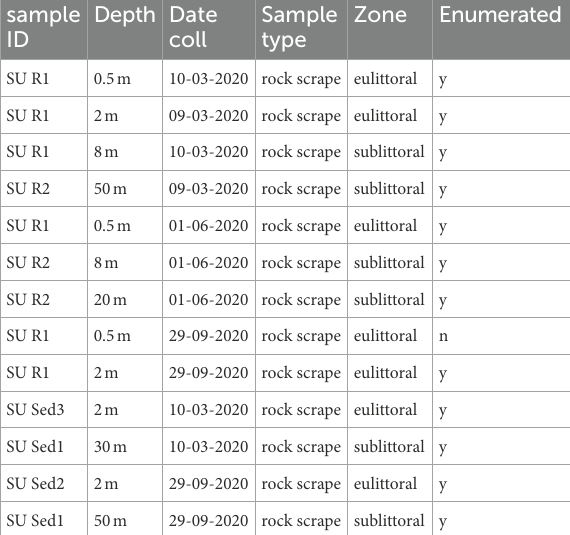
TABLE 2 List of samples examined for soft-bodied algal taxonomy and enumerated for algal biovolume (soft-bodied and diatoms